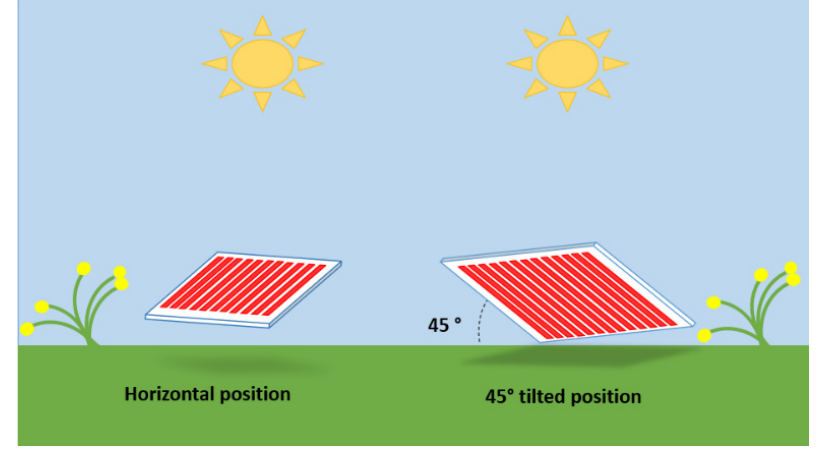
Figure 11. Measuring position.